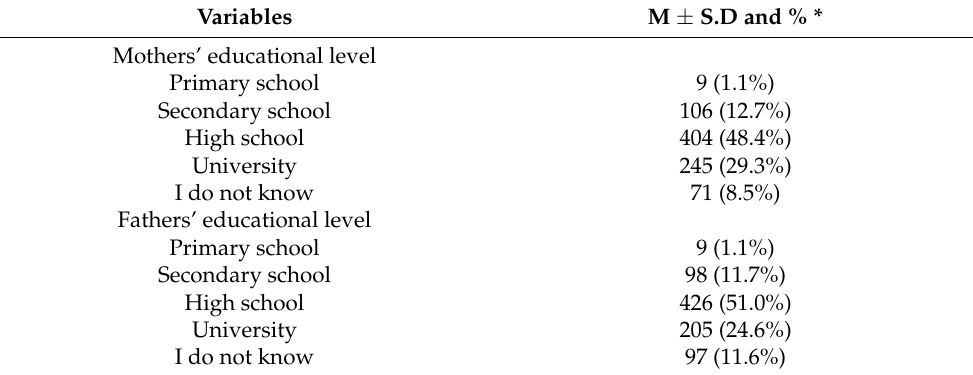
Table 1. Family-related data—parents’ level of education 1